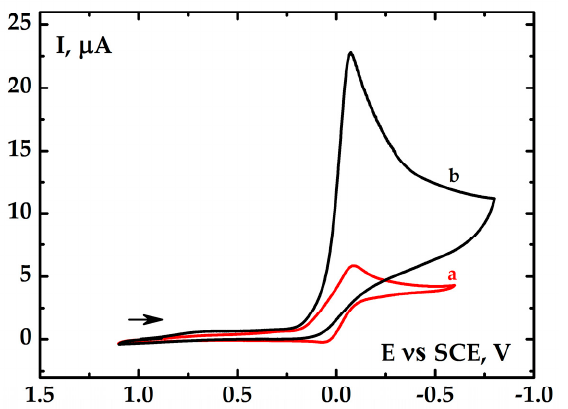
Figure 3. Cyclic voltammograms in acetonitrile (0.1 M Et 4 NClO 4 ) for ( a ) 5 mM [(salen)Fe III ] + MeCN and ( b ) 5 mM [(salen)Fe III ] + MeCN in a dioxygen atmosphere. Scan rate, 0.1 Vs − 1 , GCE (0.008 cm 2 ); SCE vs. NHE, +0.242 V, cathodic scans.